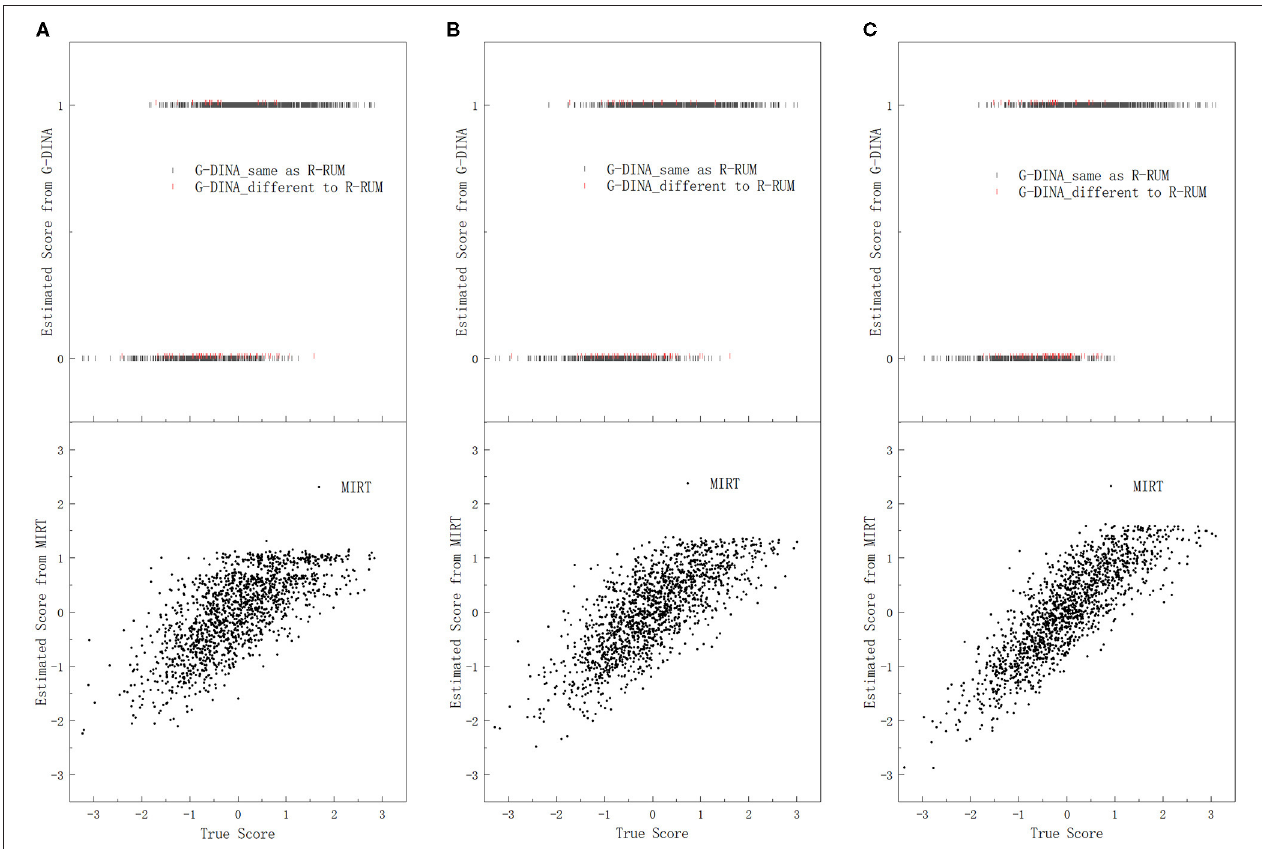
FIGURE 1 | Plots of the estimated subskill scores from the three candidate models against the true subskill scores on subskill 1. (A) SC = 0.1, (B) SC = 0.5, and (C) SC =